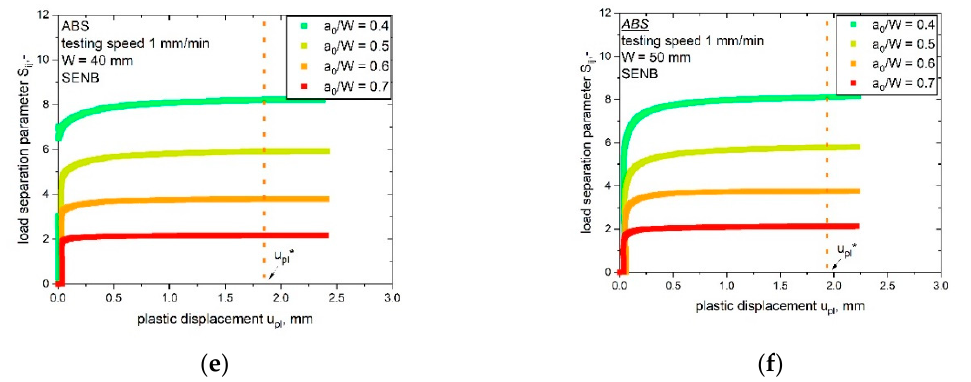
Figure 8. Evaluation of the parameter η pl from S ij -u pl curves determined from blunt notched specimens of ABS with various